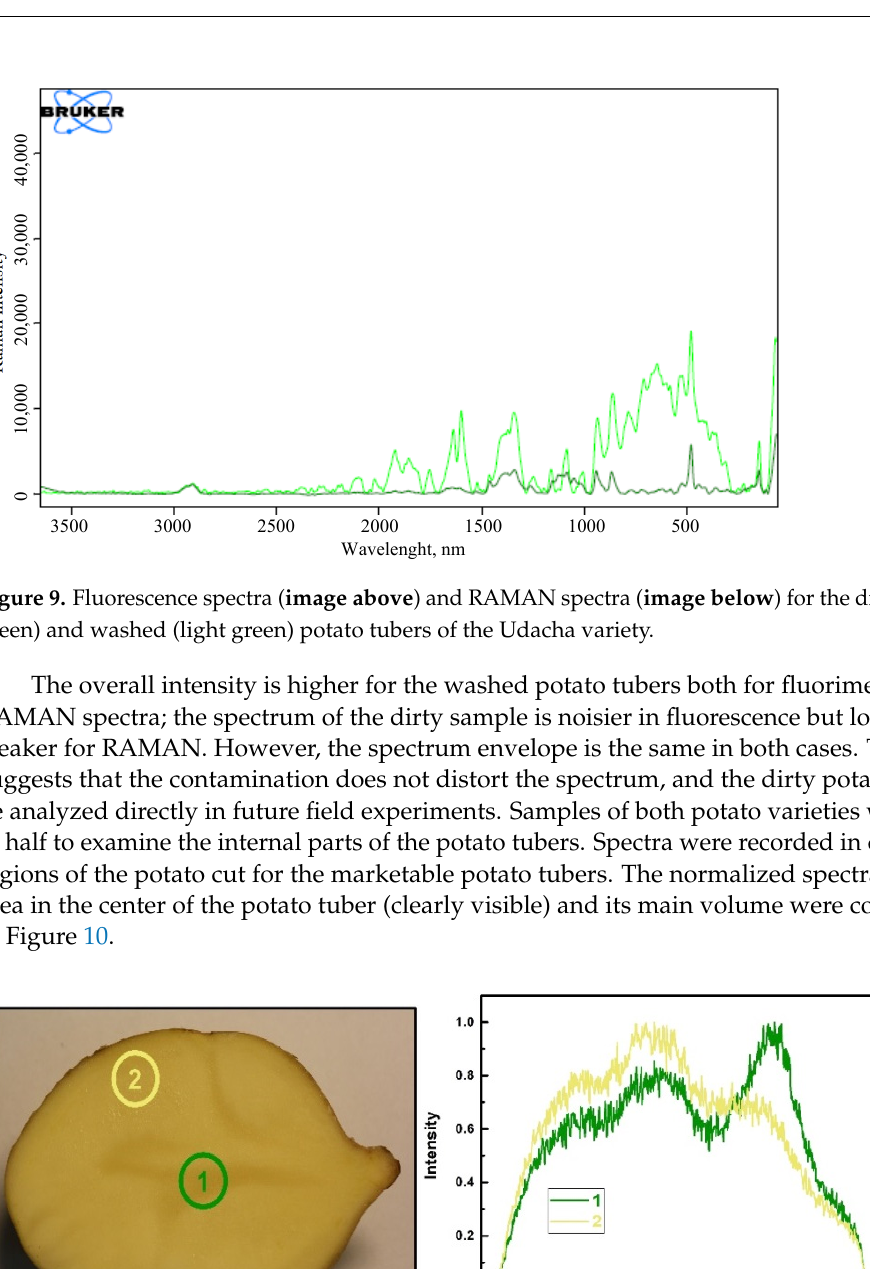
Figure 10. Example of sampling points ( left ) and fluorescence spectra ( right ) of the central part (green) and the main volume (yellow) of the potato tuber of the Udacha variety.